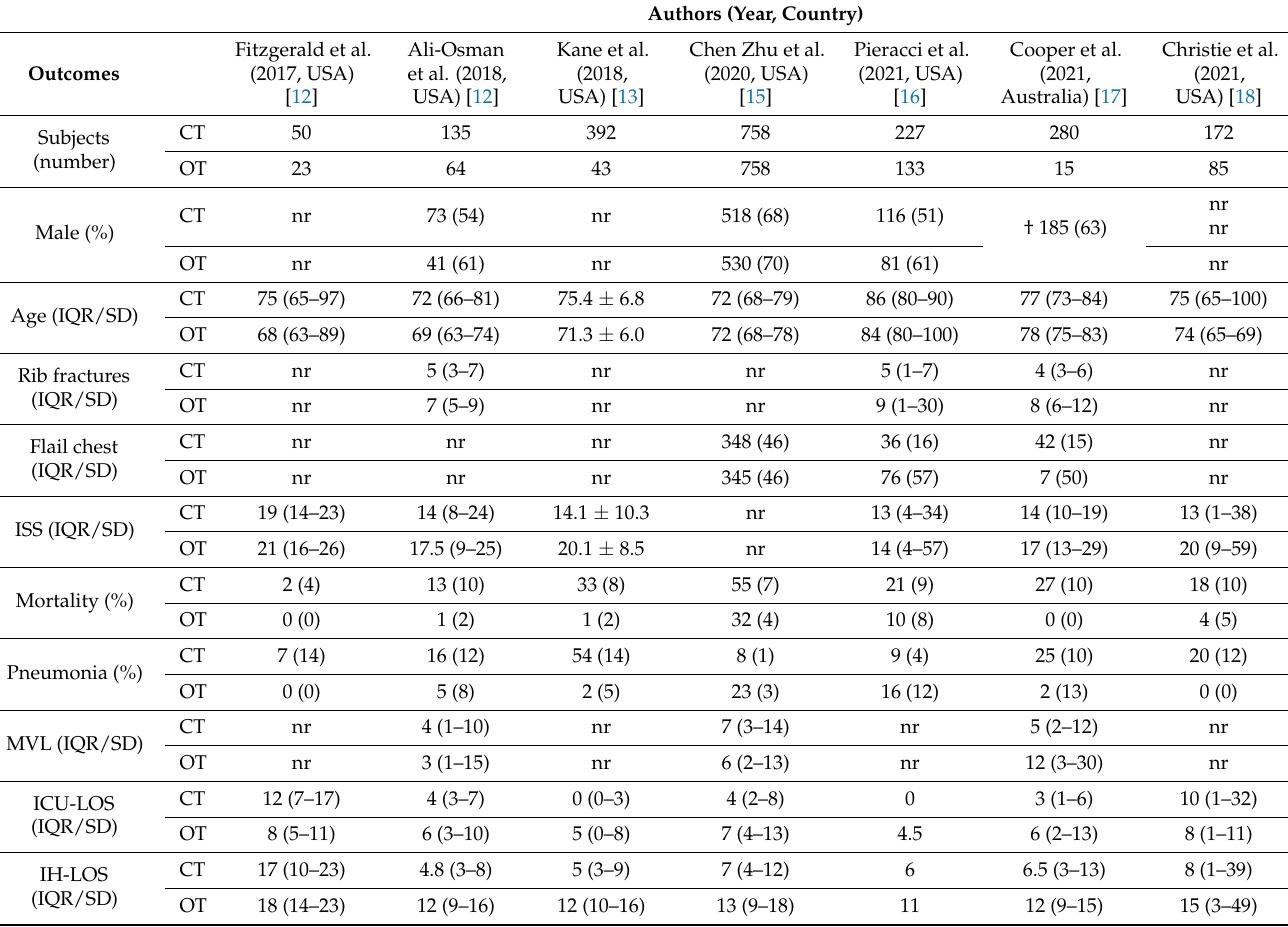
Table 3. Studies comparing conservative and operative treatment of rib